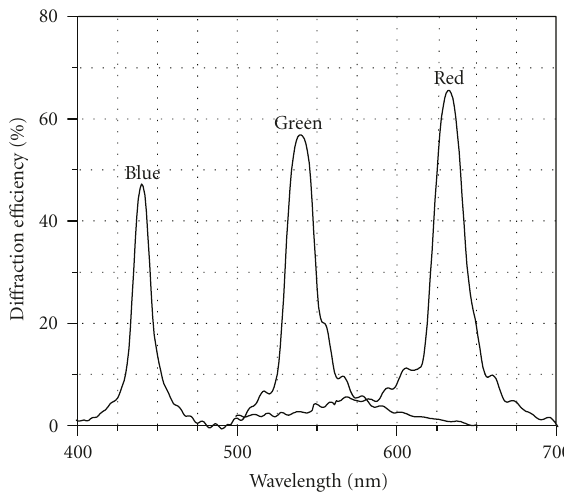
Figure 3: Spectral dependence of di ff raction e ffi ciency of bleached reflection holograms of two collimated beams for a single exposure in the blue (442nm), green (532nm), and red (632.8 nm) spectral regions.